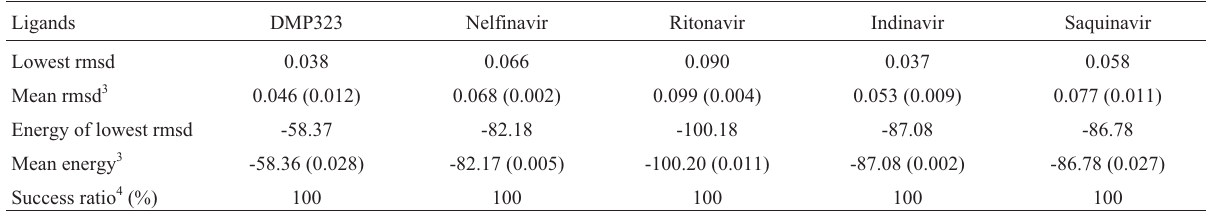
Table 1 - Rigid docking results.